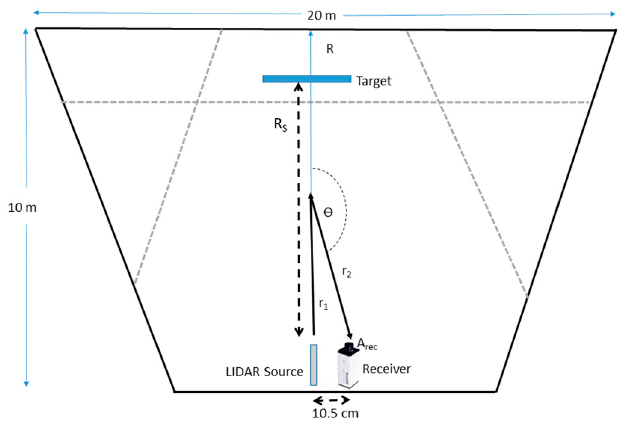
Figure 2. Top view of the model and corresponding experimental setup. Target location is seen along with single scattering trajectory where the receiver location is slightly shifted relative to the LIDAR source, and a scattering angle of θ ≠ 180° is obtained. The dashed grey lines represent the path of the 3 transmission measurements inside the aerosol chamber (see technical details in Section 3).